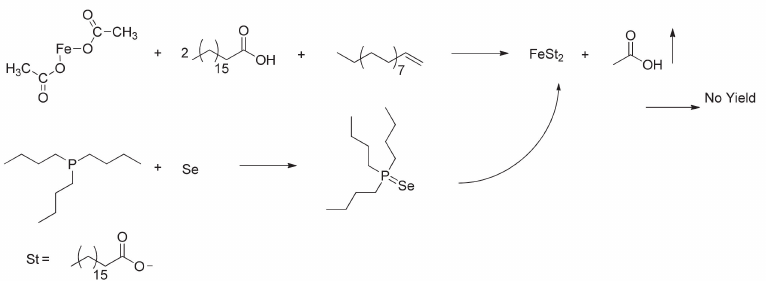
Scheme 1. Plausible reaction pathway of the synthesis of FeSe 2 by ‘hot-injection’ method employing Fe(AC) 2 and SA as an iron precursor, and TBP for solubilization of Se.